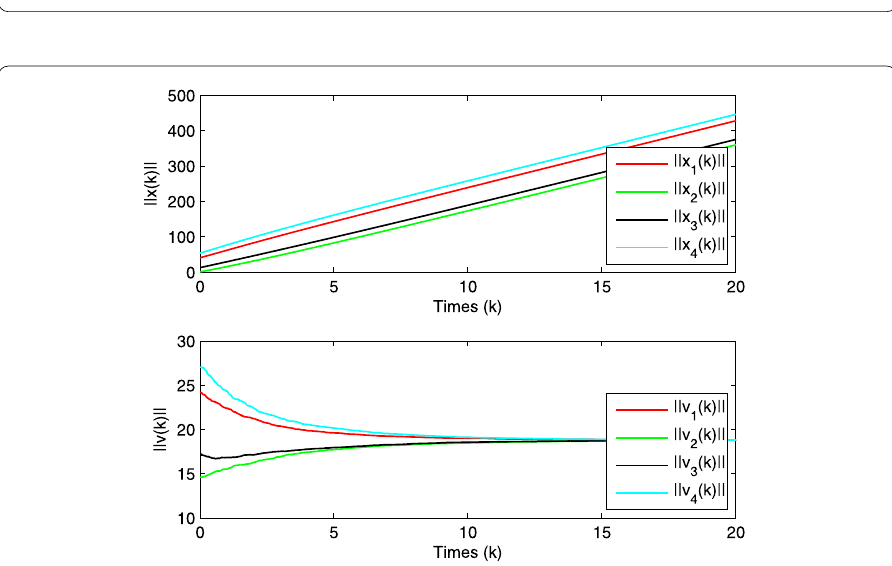
Figure 8 The norms of position and velocity trajectories with α = 0.5 in Case